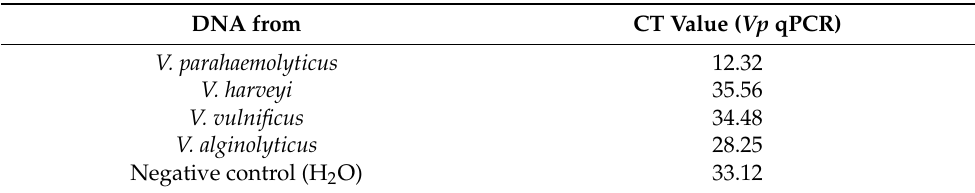
Table 3. Results of qPCR with VPF/VPR primers for Vibrio parahaemolyticus detection ( Vp qPCR) using DNA samples from a range of Vibrio species.